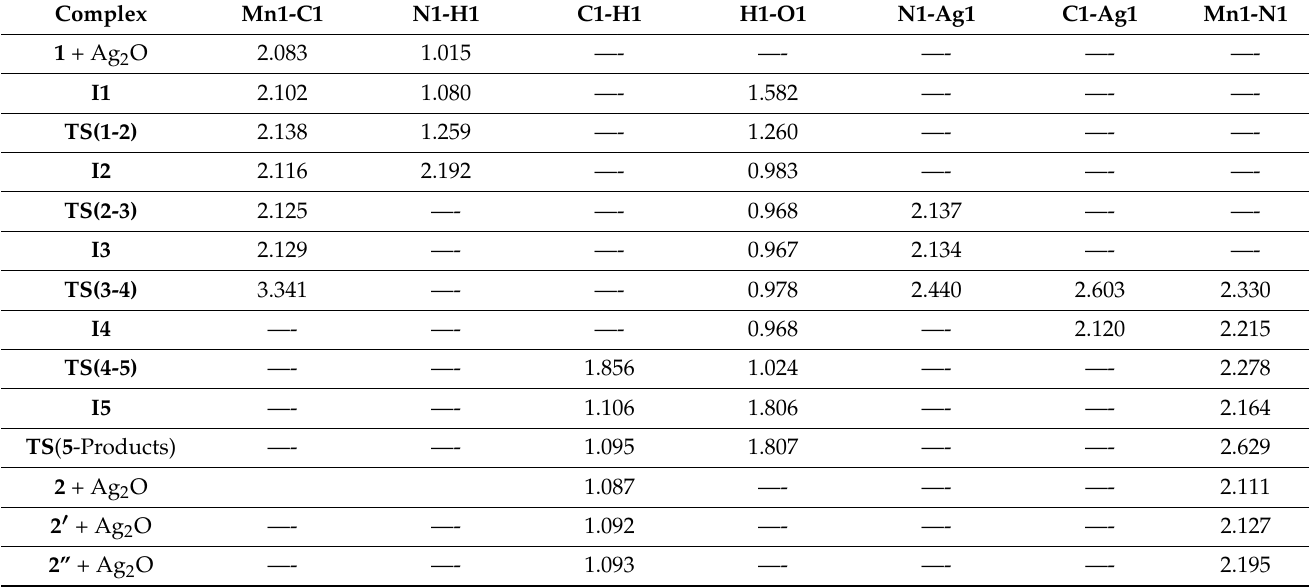
Table 1. Selected bond lengths (Å) of theoretically optimized structures (B3P86/6-31+G(d),